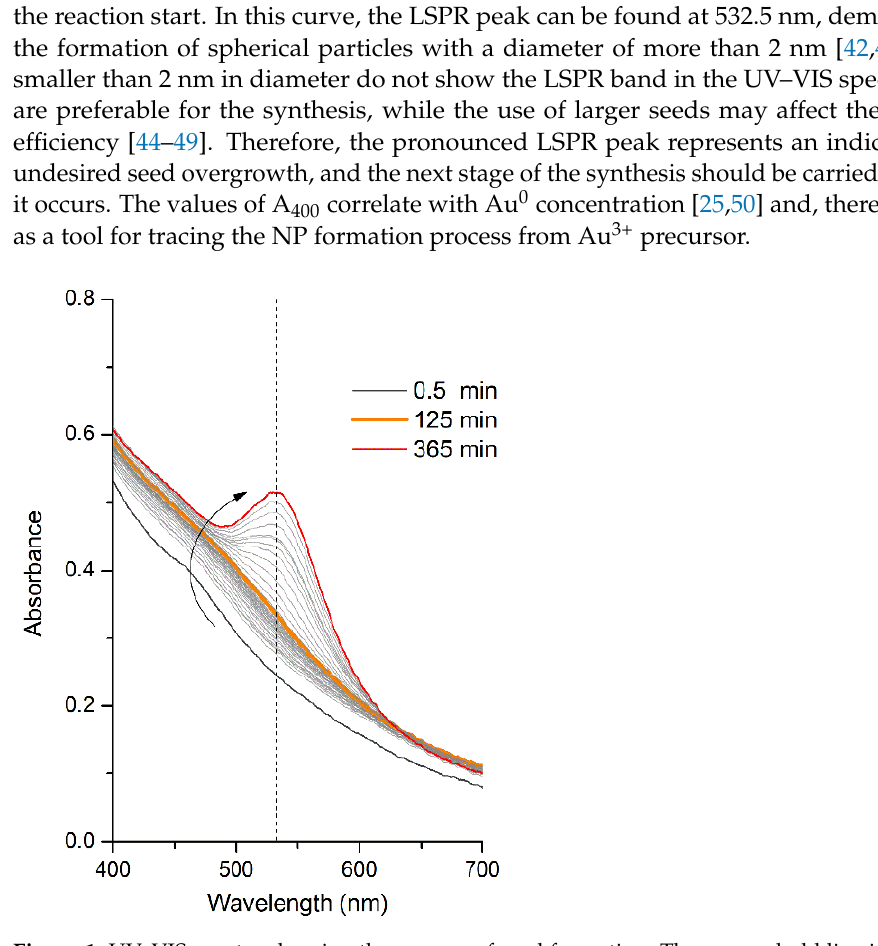
Figure 1. UV–VIS spectra showing the process of seed formation. The orange bold line indicates the beginning of seed overgrowth at 125 min. The selected wavelength position at 532.5 nm is marked by a dotted line. The arrow indicates the time